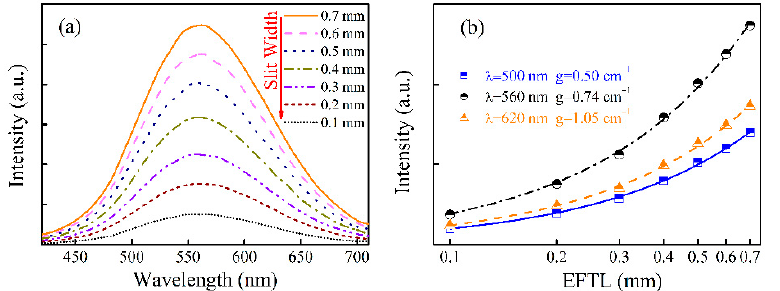
Figure 2. ( a ) ASE spectra of GC0.40 under 365 nm excitation when EFTL is changed from 0.1 to 0.7 mm. ( b ) Dependences of emission intensity on the wavelength and EFTL.